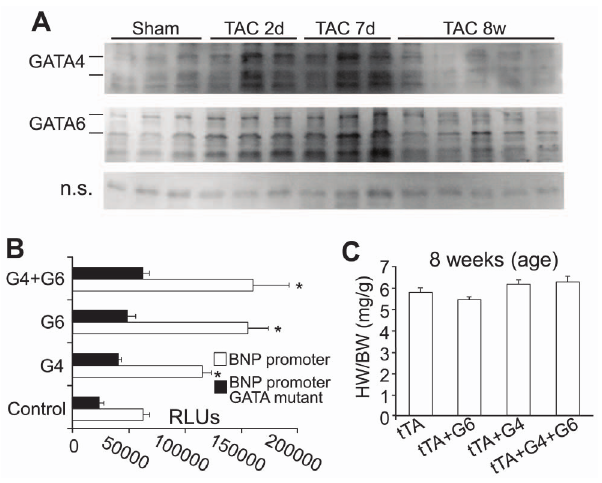
Figure 1. GATA-4 and GATA-6 are similarly induced in the adult heart with pressure overload. A, Western blot analysis of GATA-4 and GATA-6 protein expression in the adult mouse heart at baseline or after pressure overload stimulation for the indicated times. A non- specific (n.s.) band from the GATA-6 western was used to show equal loading and running conditions. B, Relative luciferase units (RLU) from a plasmid containing the luciferase reporter fused to the b-type natriuretic peptide (BNP) promoter or a mutant promoter lacking functional GATA binding sites, which was co-transfected into neonatal rat cardiomyocytes with expression plasmids encoding GATA-4 (G4), GATA-6 (G6), or both together. *P , 0.05 versus empty vector transfected control. N=3. C, Heart weight normalized to body weight (HW/BW) of the indicated genotype of cardiac-specific transgenic mice expressing either GATA4, GATA6, or both together at 8 weeks of